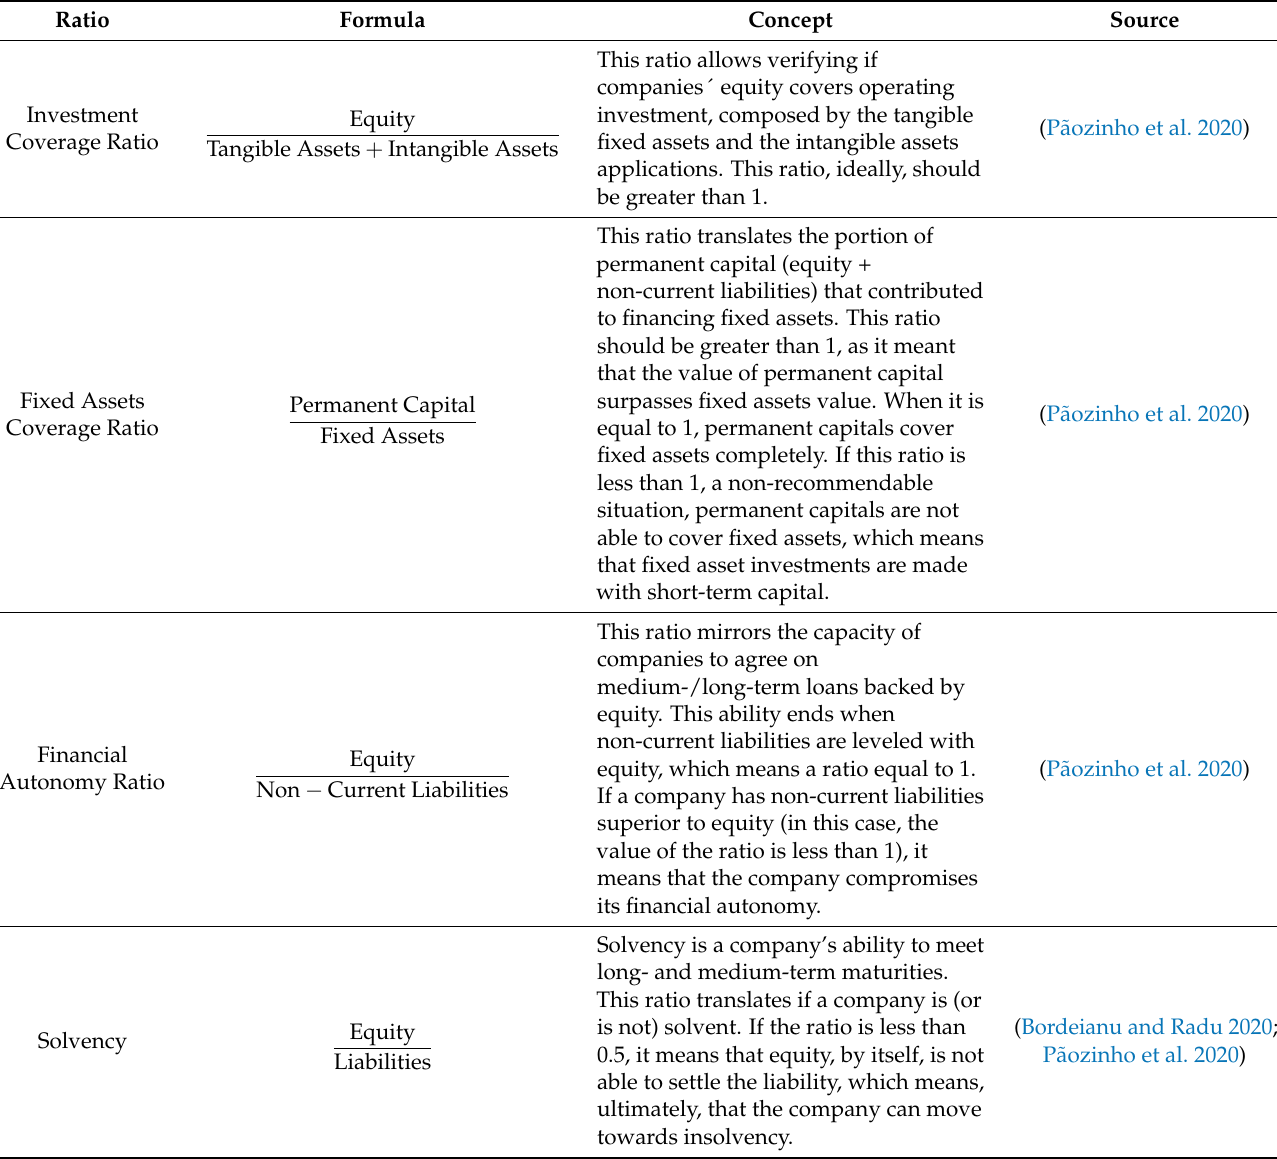
Table 2. Capital structure